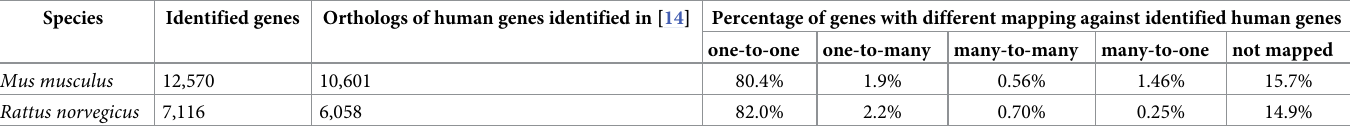
Table 3. Homologs identified in mouse and rat datasets when compared with the background list of genes (corresponding to canonical proteins) identified in human datasets (Supplementary File 2 in [14]). Species Identified genes Orthologs of human genes identified in [14] Percentage of genes with different mapping against identified human genes one-to-one one-to-many many-to-many many-to-one not mapped Mus